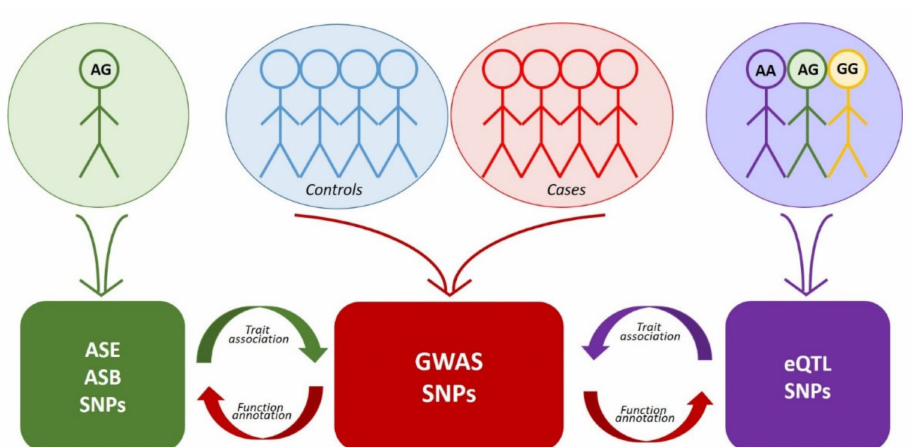
Figure 1. Interplay between the approaches to the search for functional SNPs. Colored blocks denote arrays of corresponding data. Red arrows indicate functional annotation of GWAS data using eQTL, ASE or ASB analysis. Purple arrow indicates the search for association of eQTL SNPs with traits via comparison with GWAS data. Green arrow—the same for SNPs detected by ASE or ASB